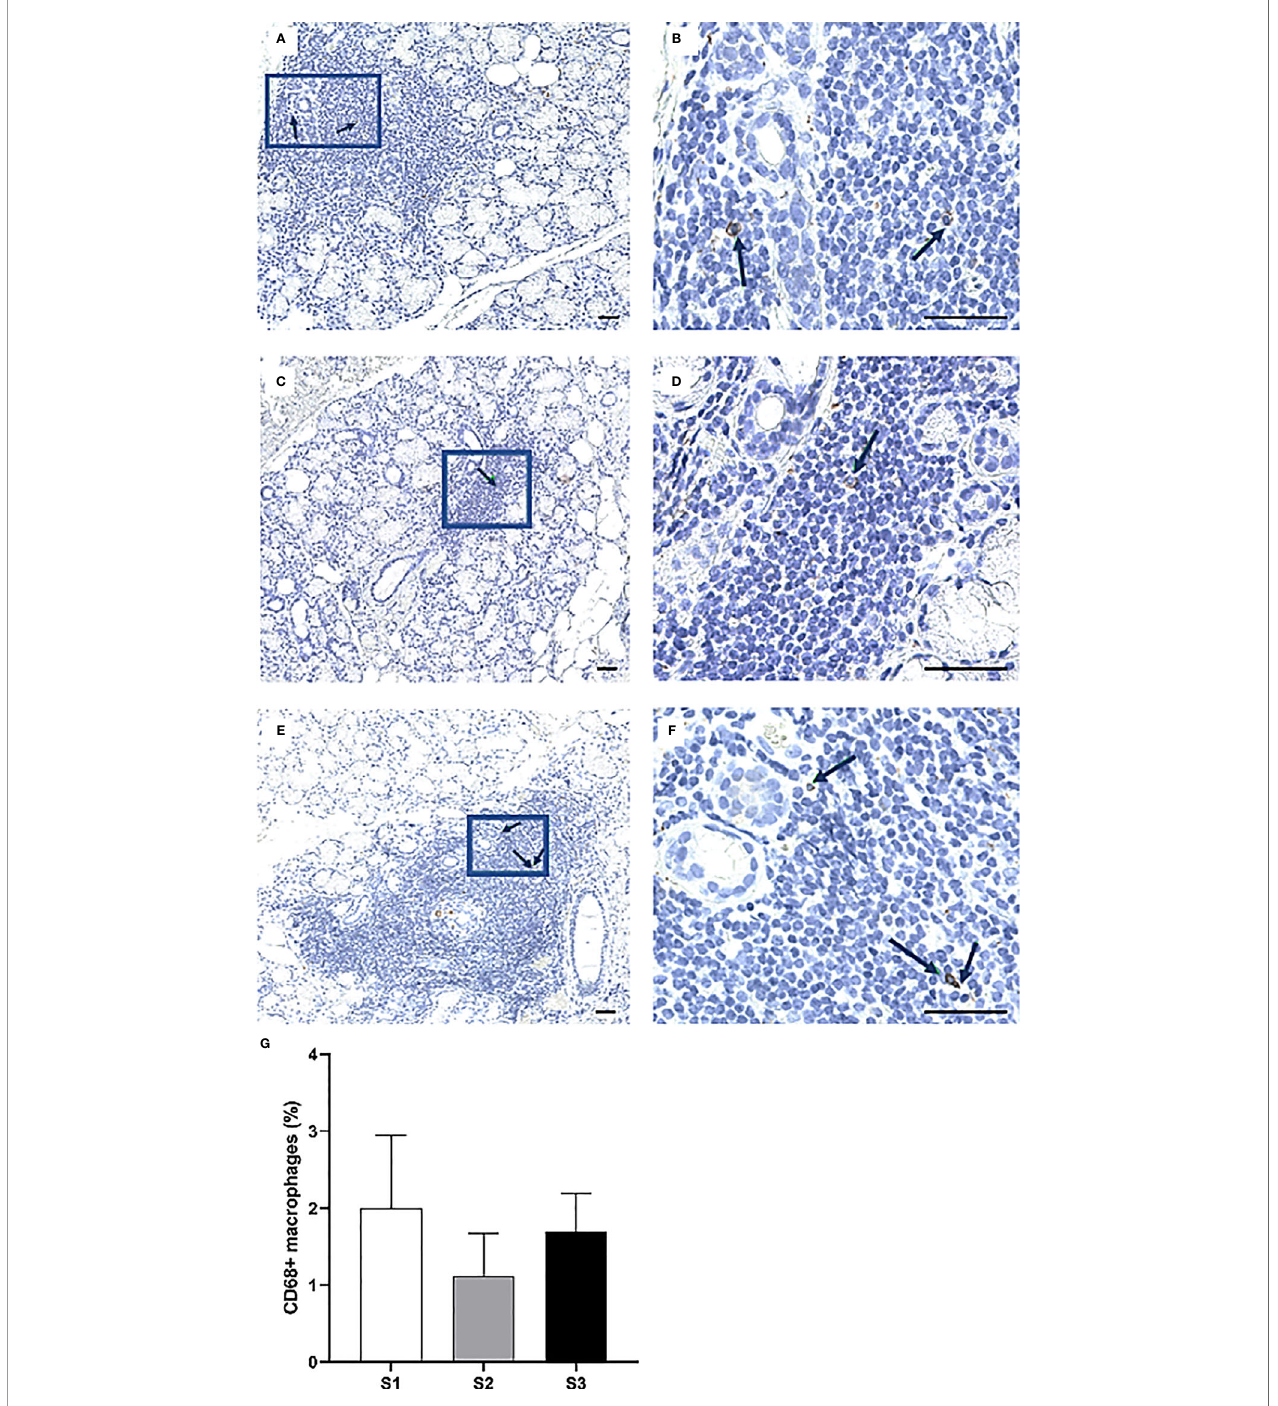
FIGURE 7 | Presence of CD68 + cells in the MSG of patients with pSS. The black arrows indicate detected CD68 + macrophages. The cells appeared co-localized and morphologically larger inside the heavier focal in fi ltrates of S3 patients (A – F) , yet the highest percentage of cells was detected in S1 lesions. Immunohistochemical staining displaying the distribution of a speci fi c immune cell in three representative examples of focal in fi ltrates in the MSG as classi fi ed into the respective in fl ammatory severity stages; S1 (A, B) , S2 (C, D) , and S3 (E, F) . Image (B) is a magni fi cation of (A) , image (D) is a magni fi cation of (C) , image (F) is a magni fi cation of (E) . Scale bar = 0.5 mm. Bars (G) indicate the mean percentage of cell-type number/total in fi ltrating mononuclear cells in each stage and error bars represent ± SEM. The Mann – Whitney U test was